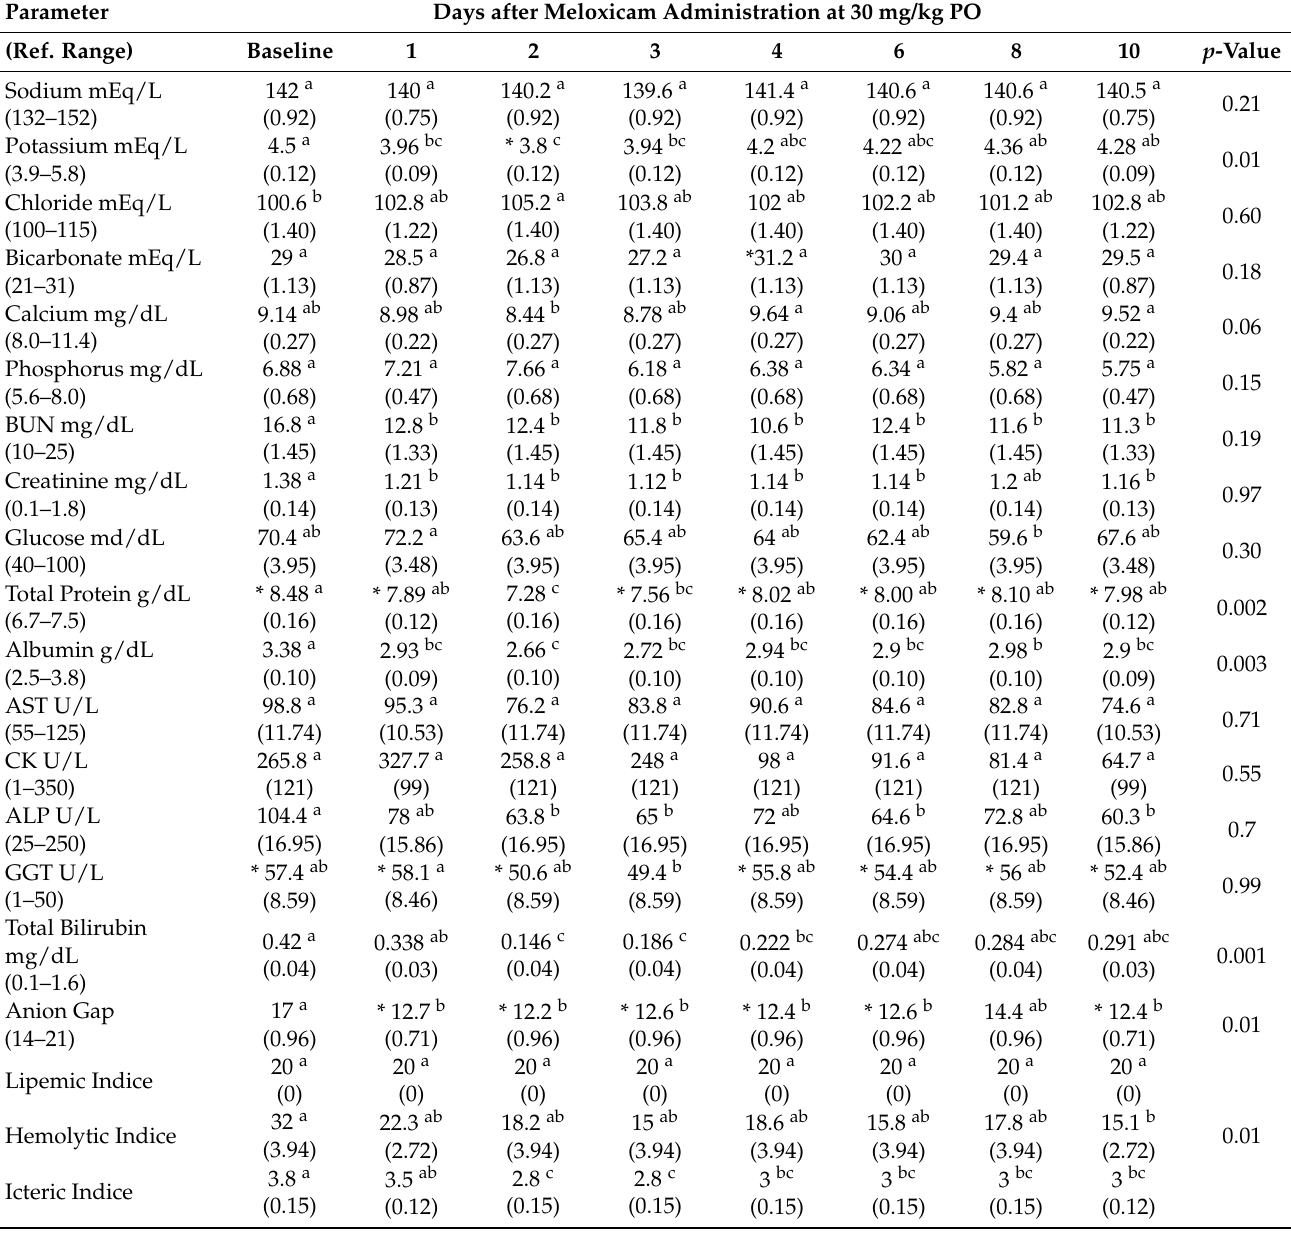
Table 5. Summary of mean ( ± SEM) serum blood chemistry parameters prior to meloxicam